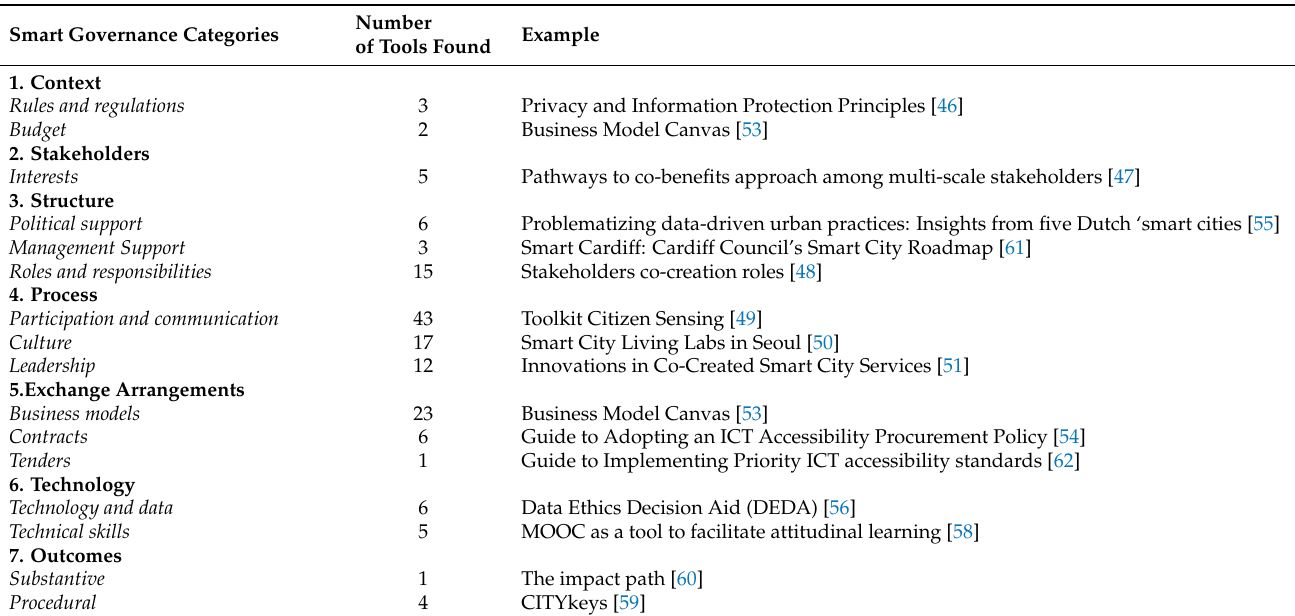
Table 6. Overview findings smart governance